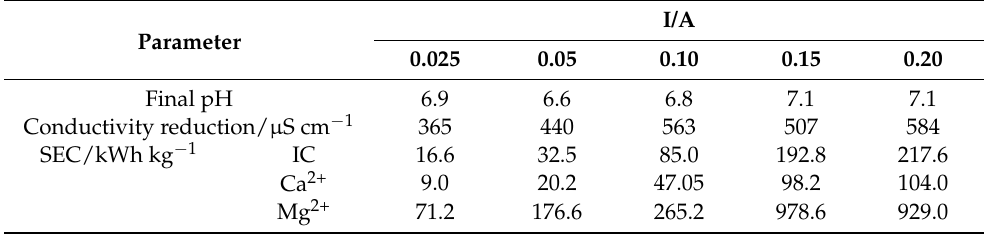
Table 2. Results for the final pH (initial pH = 7.9 ± 0.2), conductivity removal (initial conductivity = 1.7 ± 0.2 mS cm − 1 ), and specific energy consumptions per mass of inorganic carbon or calcium and magnesium removed, during electrolytic assays performed at different current intensities.